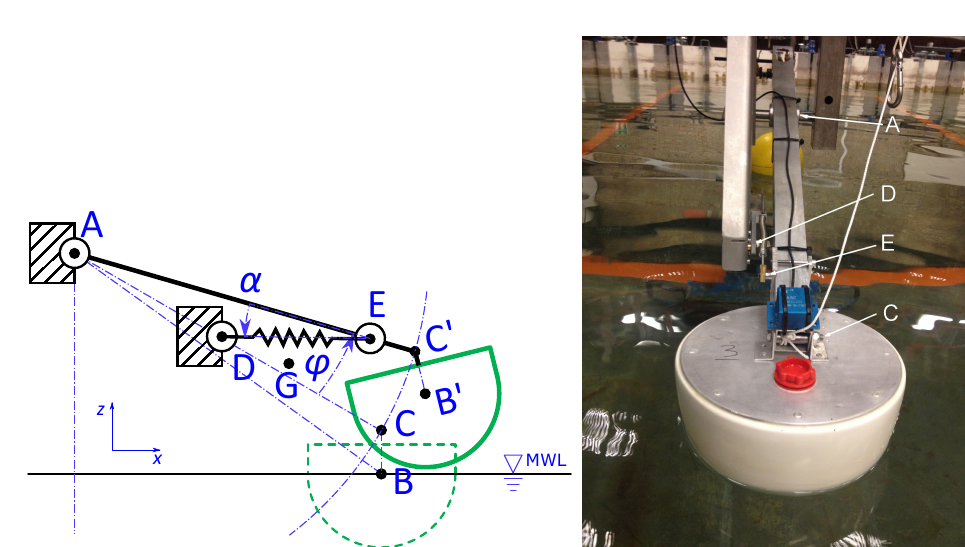
Figure 2. Left : Sketch of the WaveSpring assembly fitted to the WaveStar setup. Right : Picture of the WaveSpring model installed on the WaveStar setup in the wave